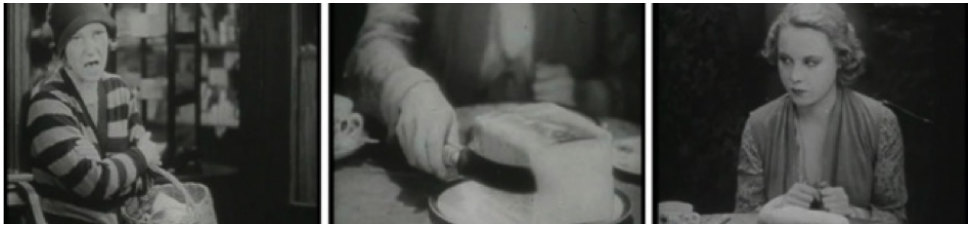
Figure 6: Meta-Diegetic Discourse in Hitchcock’s Blackmail